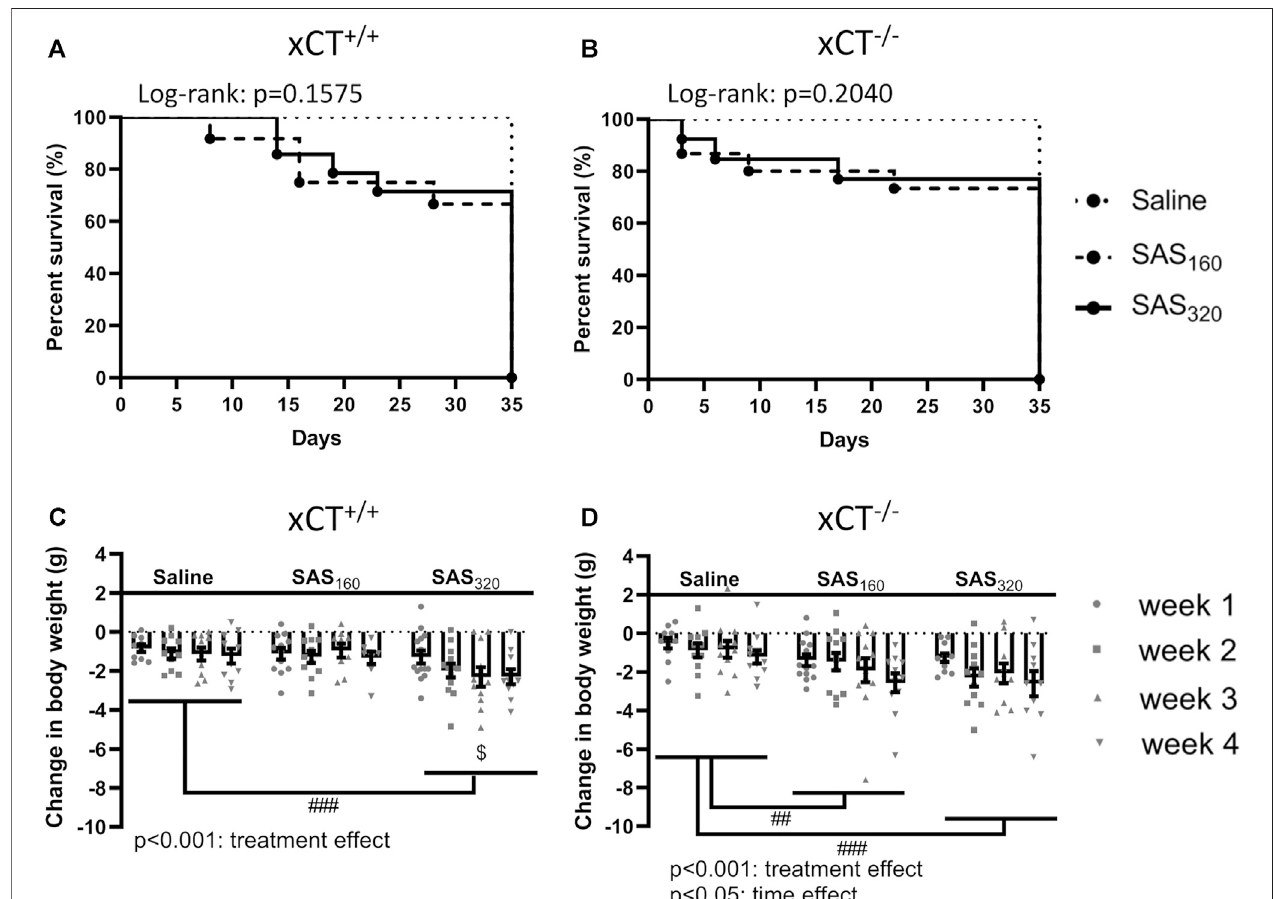
FIGURE 2 | The effect ofchronic sulfasalazine (SAS) treatment on survival and body weight. Survivalcurvesof xCT +/+ ( n (cid:2) 10 – 14 mice/group) (A) and xCT − / − mice ( n (cid:2) 11 – 15mice/group) (B) weredetermined usingaKaplan-Meier curve andanalyzedwithaLog-rank test.Bodyweight ofxCT +/+ ( n (cid:2) 10 – 14mice/groupat thestartof theexperiment, n (cid:2) 8 – 11mice/groupafterfourweeksoftreatment) (C) andxCT − / − mice( n (cid:2) 11 – 15mice/groupatthestartoftheexperiment, n (cid:2) 10 – 11mice/groupafter fourweeksoftreatment) (D) wasrecordedweeklyandplottedasthechangecomparedtobaseline(i.e.theweightatthestartofthetreatment).Dataarepresented as mean ± SEM and analyzed using a two-way ANOVA followed by a Sidak ’ s multiple comparisons test for each dose of SAS compared to saline. ## p < 0.01, ### p < 0.001: for treatment effect over all timepoints; $ p < 0.05: for treatment effect at one speci fi c timepoint.